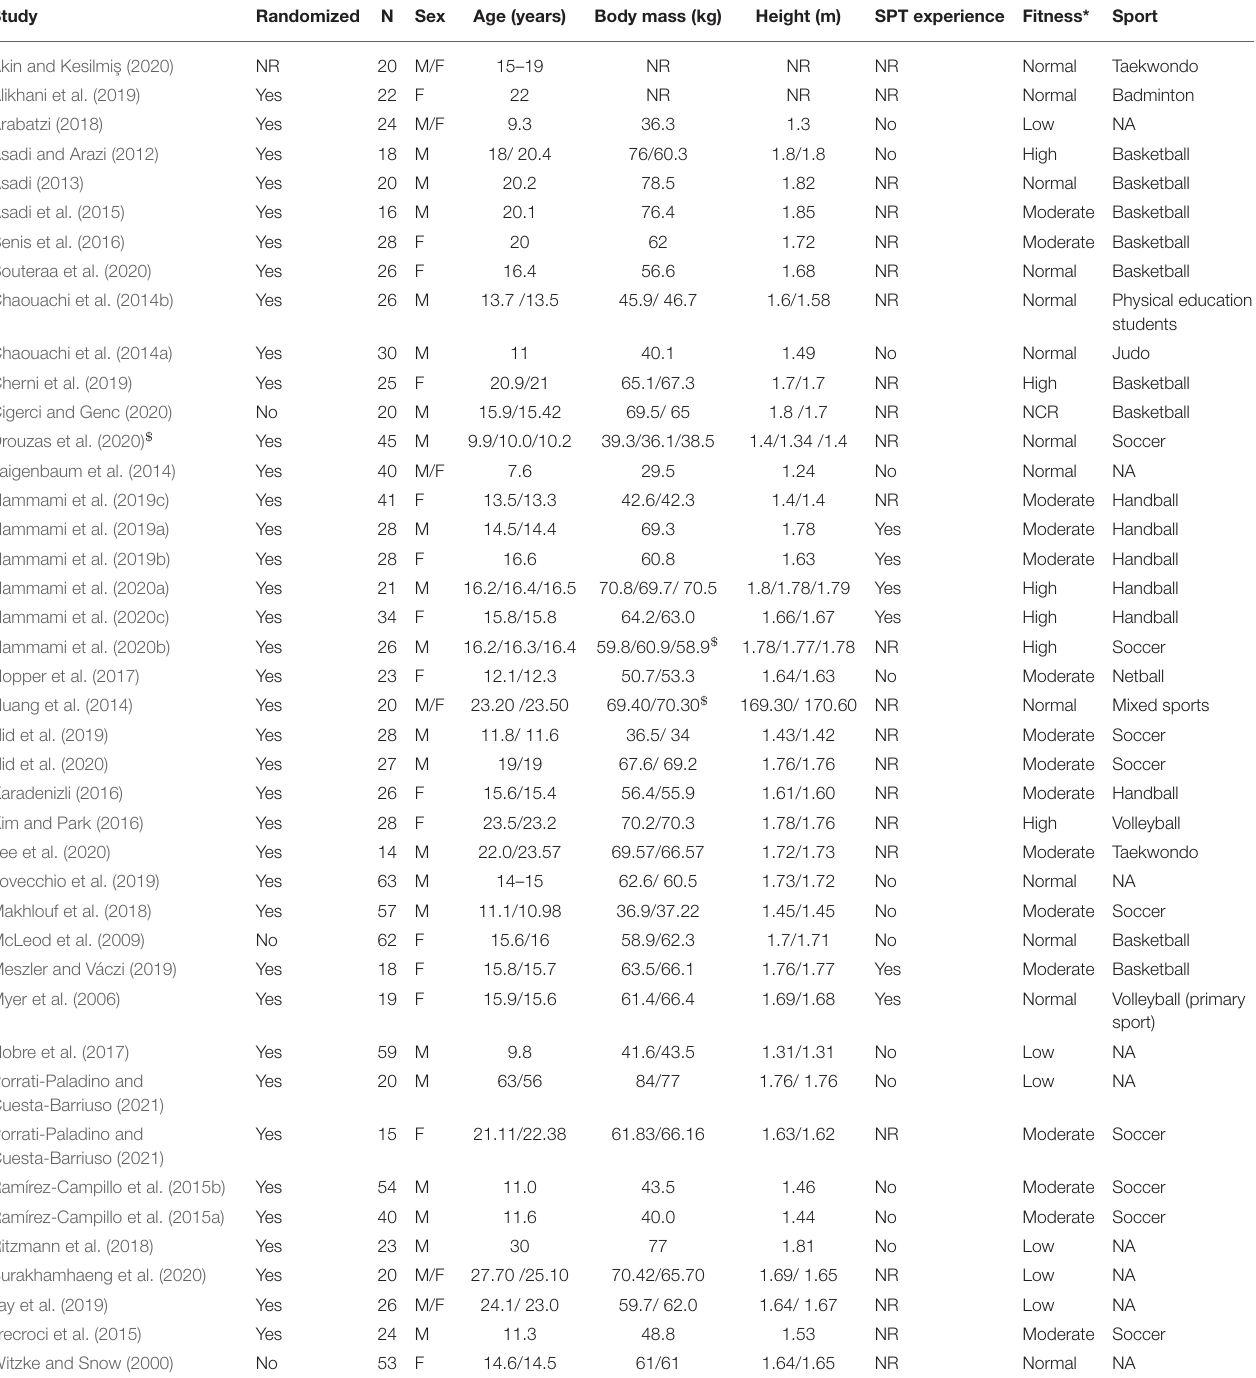
TABLE 2 | Participant’s characteristics the included studies $